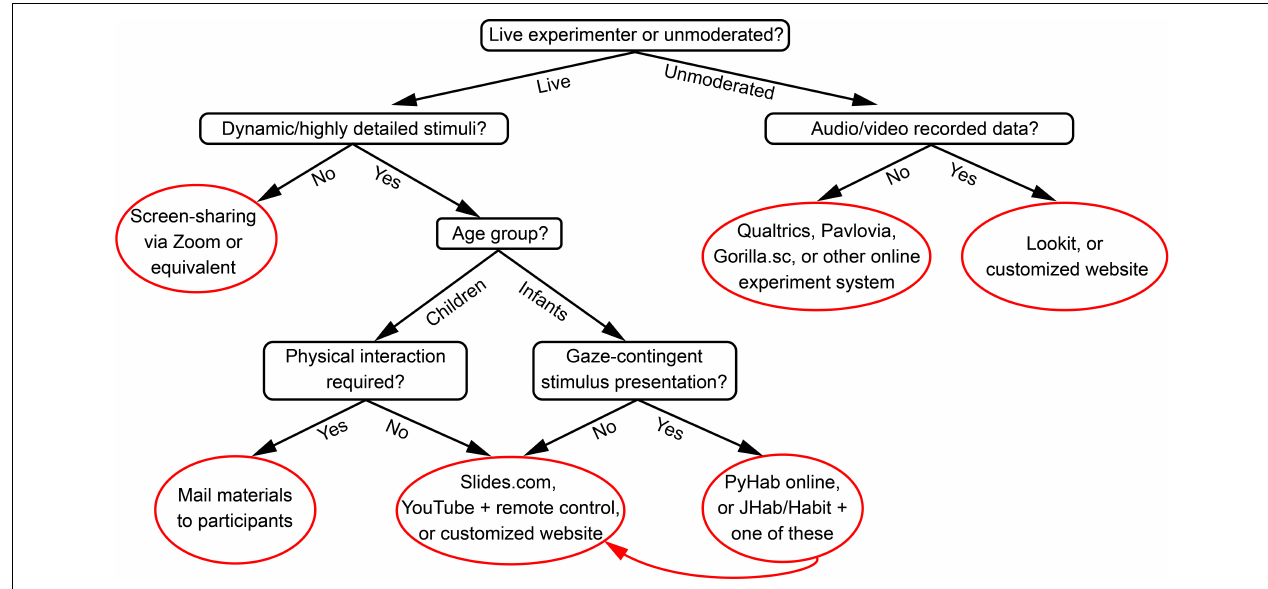
FIGURE 1 | A quick-reference flow-chart for determining which types of paradigms might be appropriate for different study designs. See text for detailed considerations of each decision point and solution.